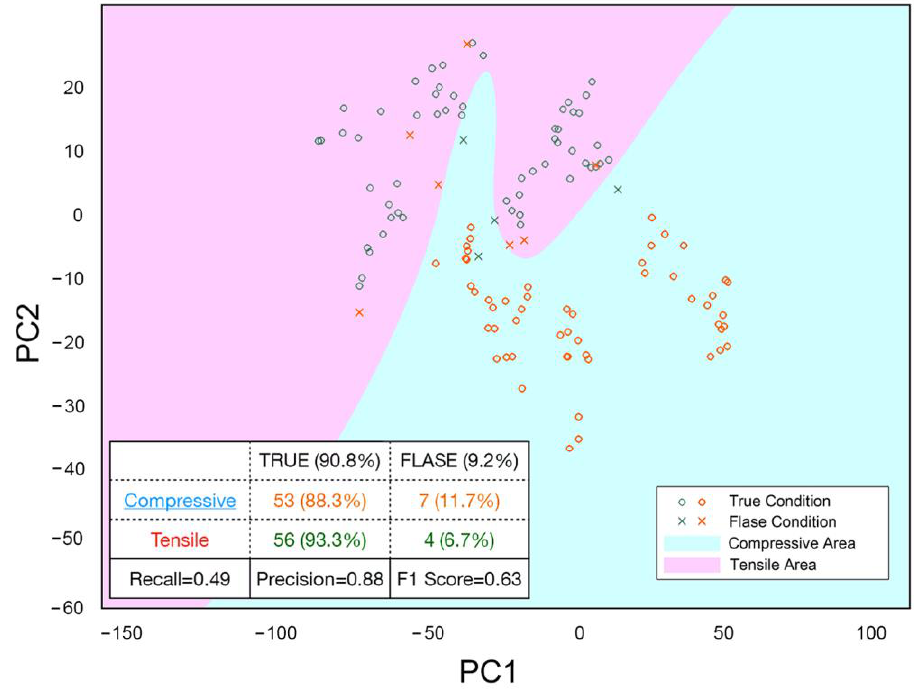
Figure 10. Cross-validation test result with a confusion matrix.